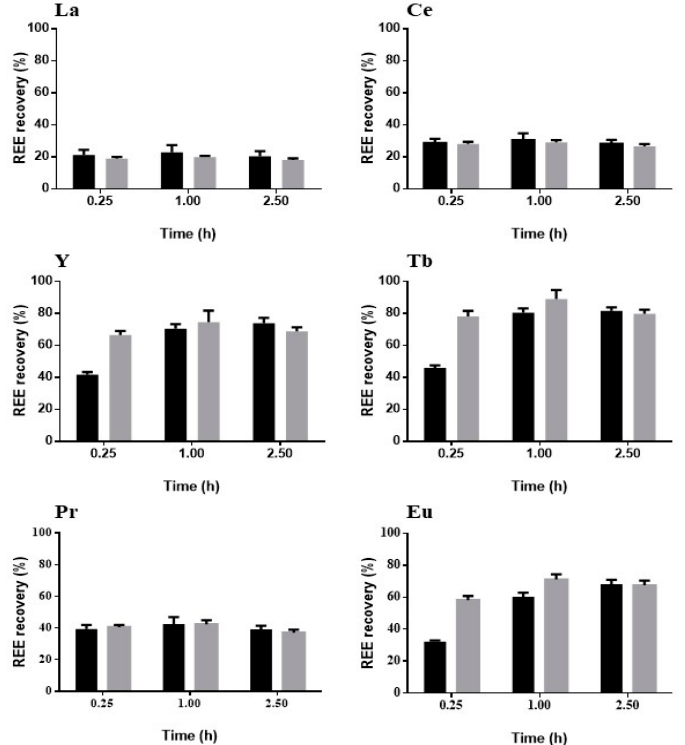
Figure 8. REE recovery from zeolite using HNO 3 at two different concentrations, 0.1 M ( ) and 0.5 M